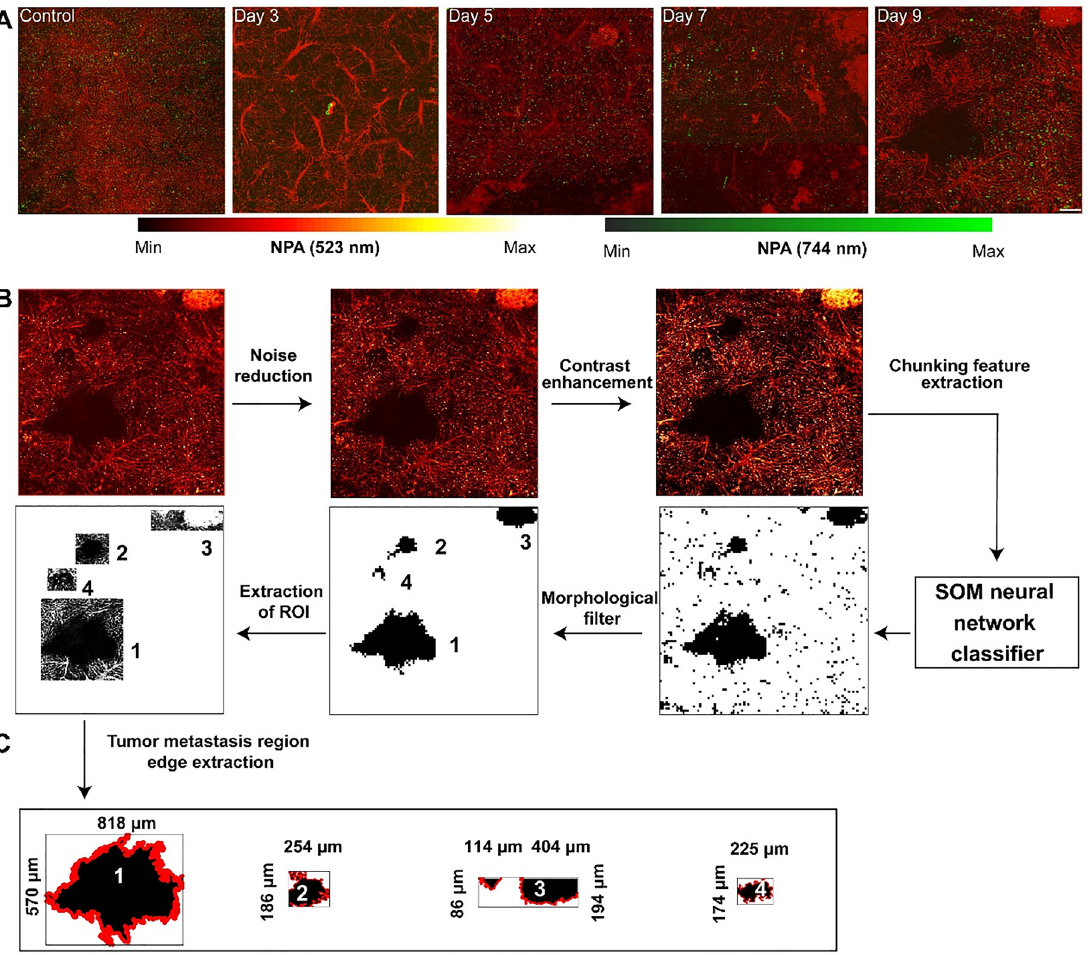
Figure 5: Long-term intravital photoacoustic imaging of liver metastases and the SOM ’ s automatic detection of metastases. (A) Intravital photoacoustic imaging of tfRFP-B16 liver metastases at different times. Red: hepatic sinusoid; Green: KCs; scale bar: 200 μ m. (B)SchematicdiagramoftheexperimentalprogressoftheSOM ’ sautomaticdetectionoftheregionsofinterest(ROI)oftumormetastasesfrom photoacousticimagesonDay9.(C)Thedifferentshapesandsizesoffourtumormetastases(labeledas1,2,3,and4)obtainedaftertheSOM ’ s automatic